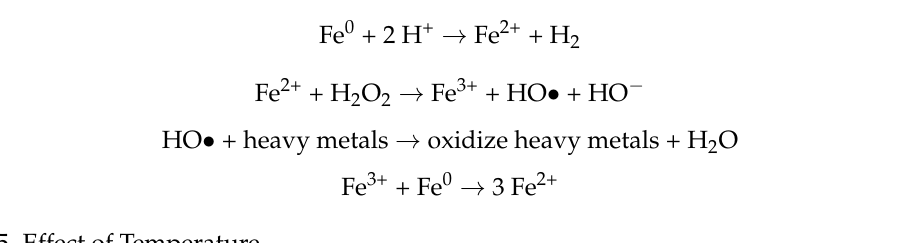
Figure S2: The XRD results for all samples (SB = sodium borate, Na 2 B 4 O 7 ; Q = quartz; K = kaolinite; H = halloysite; Fe = iron Fe 0 ); Figure S3: The FTIR spectra of nZVI, Gr and Gr-nZVI before and after treatment; Figure S4: Effect of adsorbent dosage on heavy metal ((a) Pb, (b) Cu, (c) Co, (d) Cd, (e) Ni,